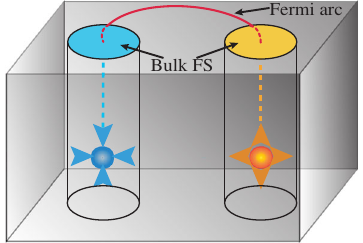
FIG. 4. A pair of Weyl points with opposite chirality projected onto the surface of the Brillouin zone along one direction and connected by the Fermi arc. If the Fermi surface of the bulk state and the Fermi arc are projected together, the Fermi arc will connect two bulk Fermi surfaces, each of which covers a Weyl